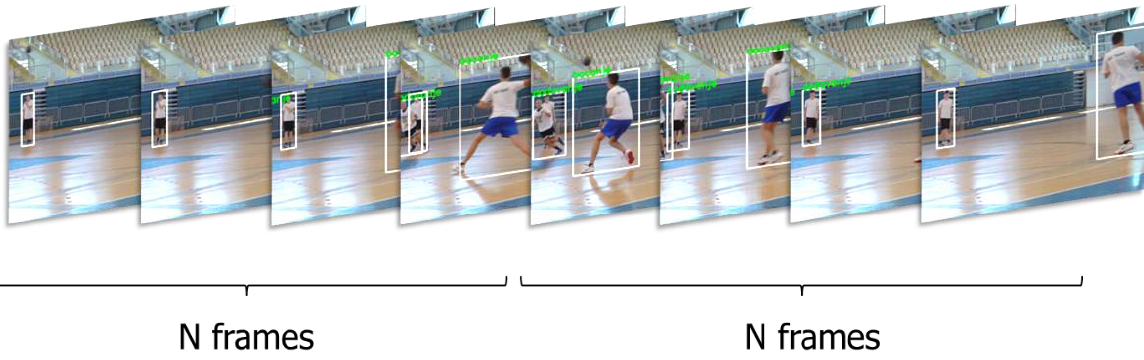
Figure 5. A sliding window of the candidate sequences with window length N that depends on the input length of the action recognition model and on the frame selection strategy.